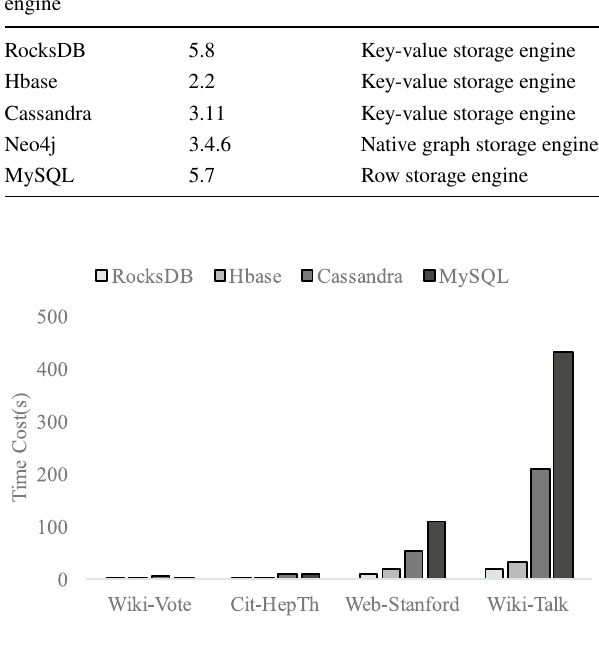
Fig. 3 The performance of data load